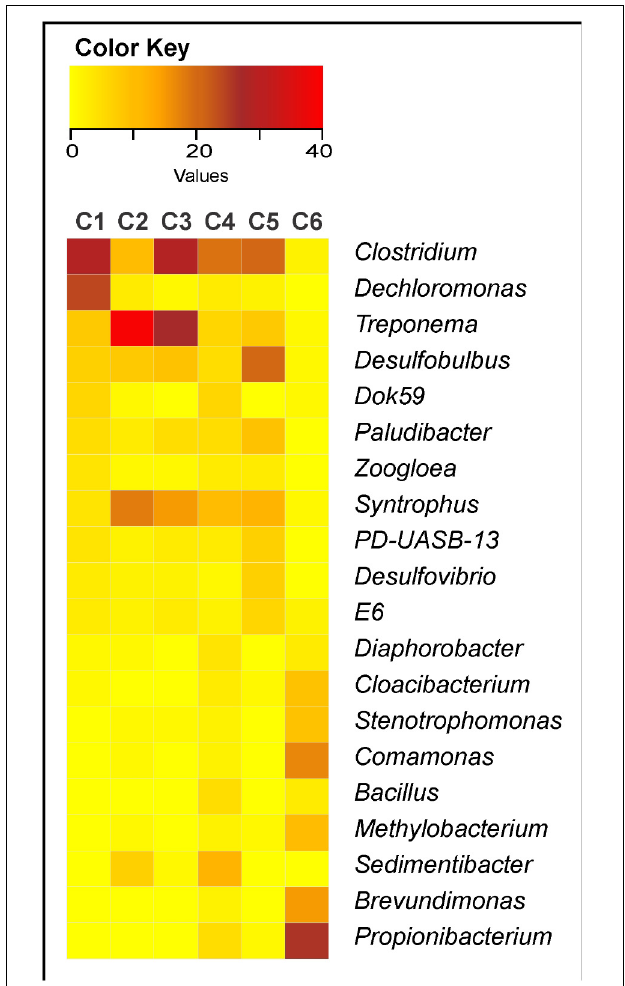
FIGURE 3 | Heatmap of the 20 most abundant bacterial genera found in 19 sewage sludges from São Paulo State, Brazil. C1, cluster 1 ( n = 3 samples); C2, cluster 2 ( n = 2 samples); C3, cluster 3 ( n = 2 samples); C4, cluster 4 ( n = 6 samples); C5, cluster 5 ( n = 4 samples); and C6, cluster 6 ( n = 2 samples). Red color, most abundant genus; Yellow, least abundant genus.